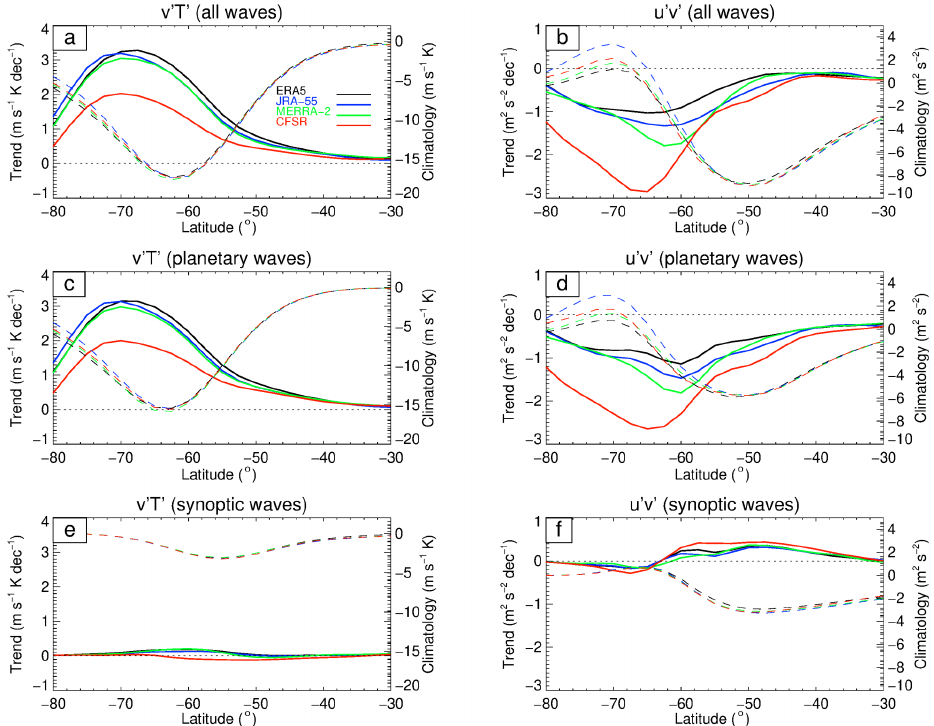
Figure 6. November trend and climatological mean in 30 to 100hPa vertically integrated eddy heat flux v (cid:48) T (cid:48) (left column) and eddy momentum flux u (cid:48) v (cid:48) (right column) due to all waves (a, b) , planetary waves (c, d) , and synoptic waves (e, f) from 1980 to 2001 for ERA5 (black), JRA-55 (blue), MERRA-2 (green), and CFSR (red). The trend in v (cid:48) T (cid:48) is indicated by the solid lines (left y axis; units: ms − 1 K per decade) and the climatological mean by the dashed lines (right y axis; units: ms − 1 K). The trend in u (cid:48) v (cid:48) is indicated by the solid lines (left y axis; units: m 2 s − 2 per decade) and the climatological mean by the dashed lines (right y axis; units: m 2 s − 2 ). None of the trends are significant at the 5% significance level. Note that for both columns the right and left axes have different